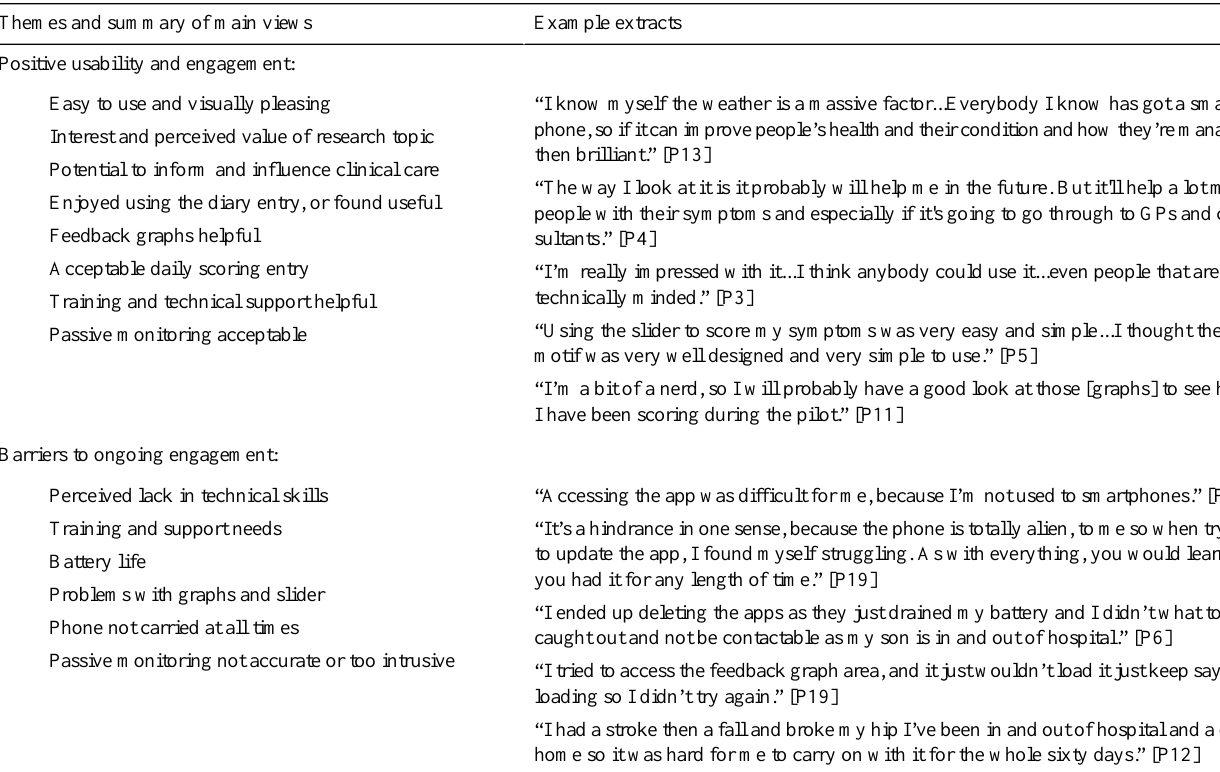
Table 3. Key themes and quotes arising from participant feedback after data collection.